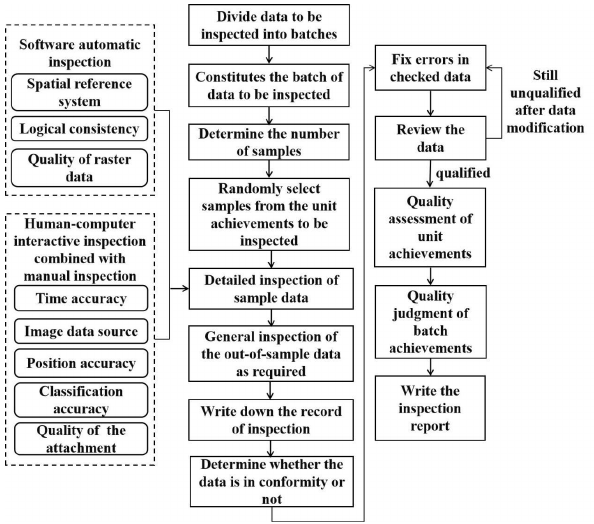
Figure 2. Inspection process of GlobeLand30 update